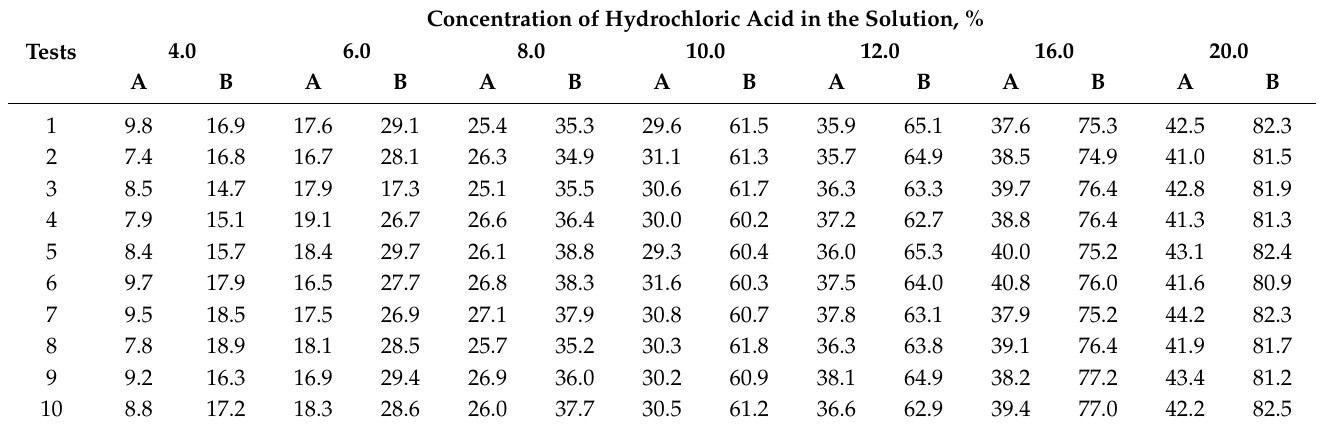
Table 4. Zinc extraction (%) without mechanical activation (A) and with mechanical activation (B).